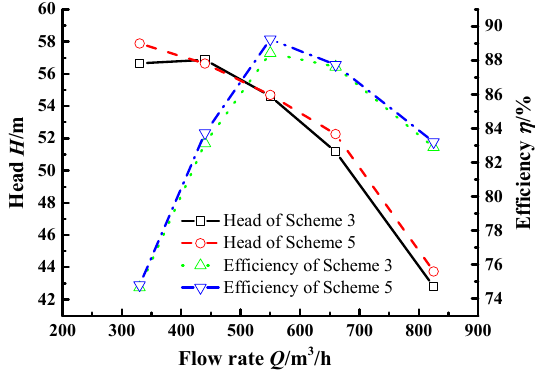
Figure 18. Hydraulic performances of Schemes 3 and 5.